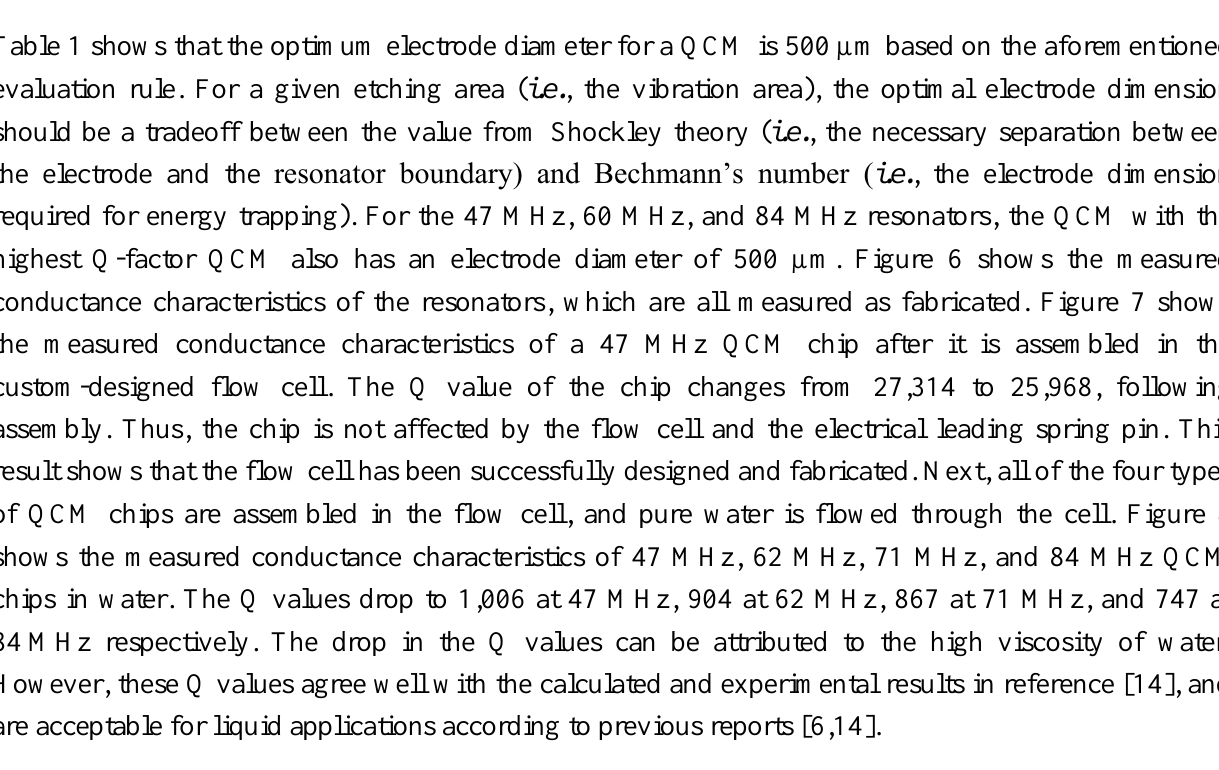
Figure 6. Typical measured vibration characteristics for 47 MHz, 60 MHz, 73 MHz and 84 MHz